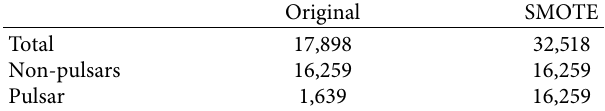
Table 4: HTRU2 dataset count after applying SMOTE